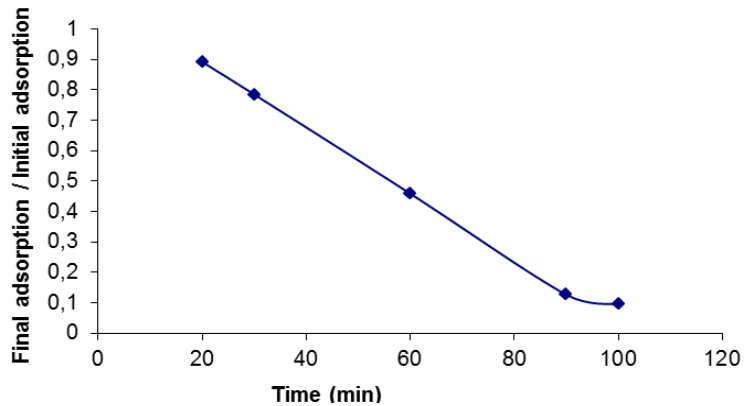
Figure 4. A dsorption of the azo dye Orange II using albumin.